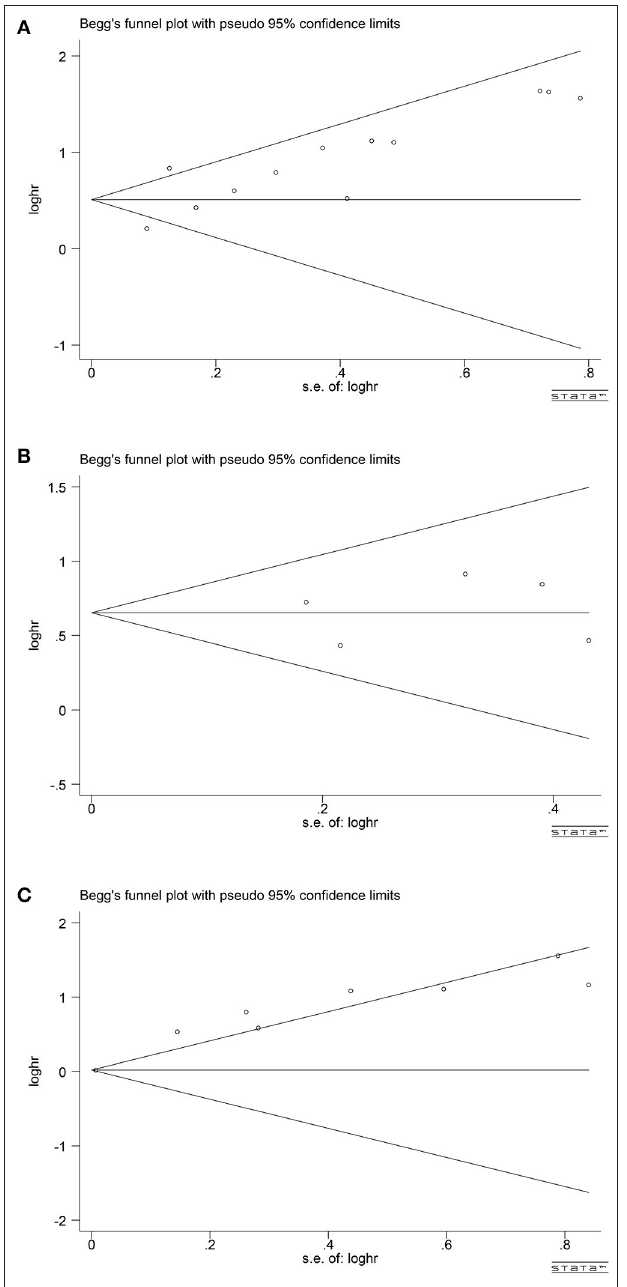
FIGURE 8 | Analyses of publication bias for the relationship between NLR/CRP/PLR and OS (A) Begger’s funnel plot for NLR. (B) Begger’s funnel plot for CRP. (C) Begger’s funnel plot for PLR.